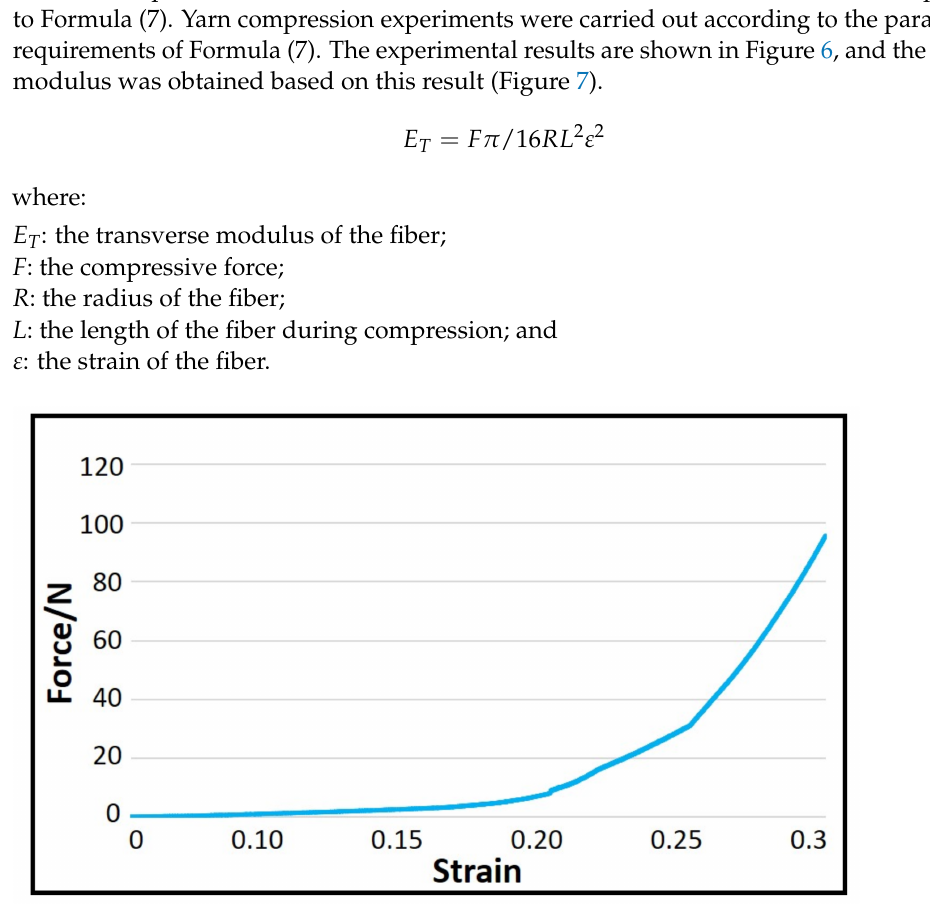
Figure 6. Transverse compressive curve of the Kevlar yarns.